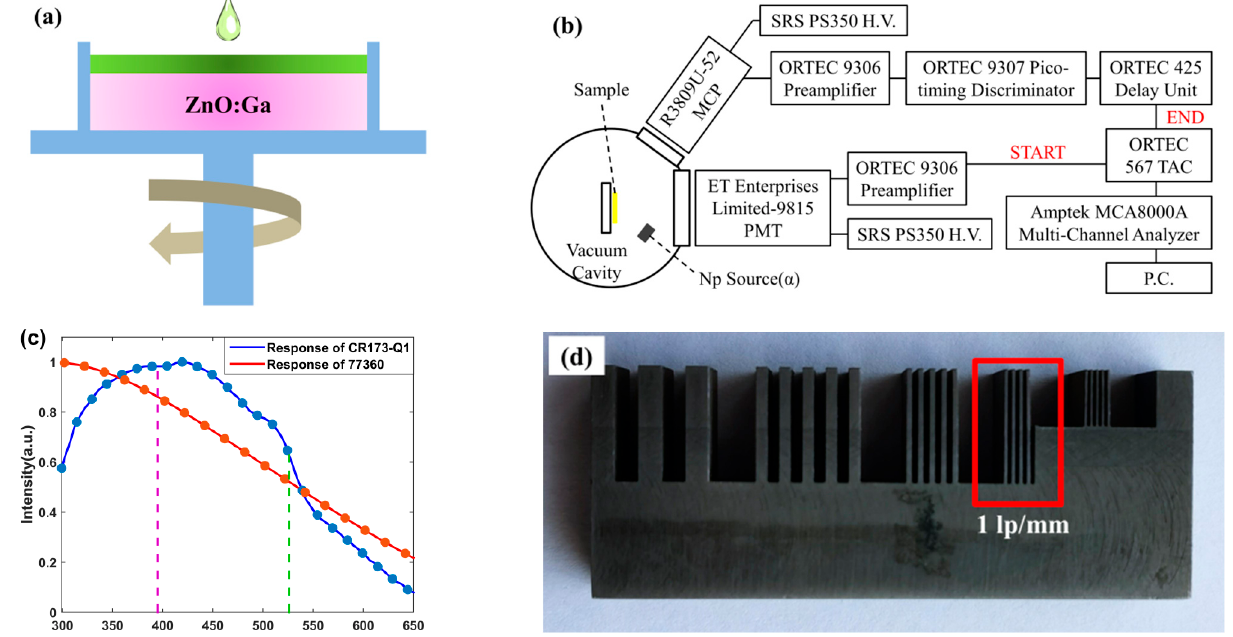
Figure 1. ( a ) Schematic diagram of the composite preparation. ( b ) Diagram of the TCSPC system. ( c ) Spectral response of the Newport-77360 PMT and the Hamamatsu CR173-Q1 PMT. ( d ) Photograph of a standard pattern plate.